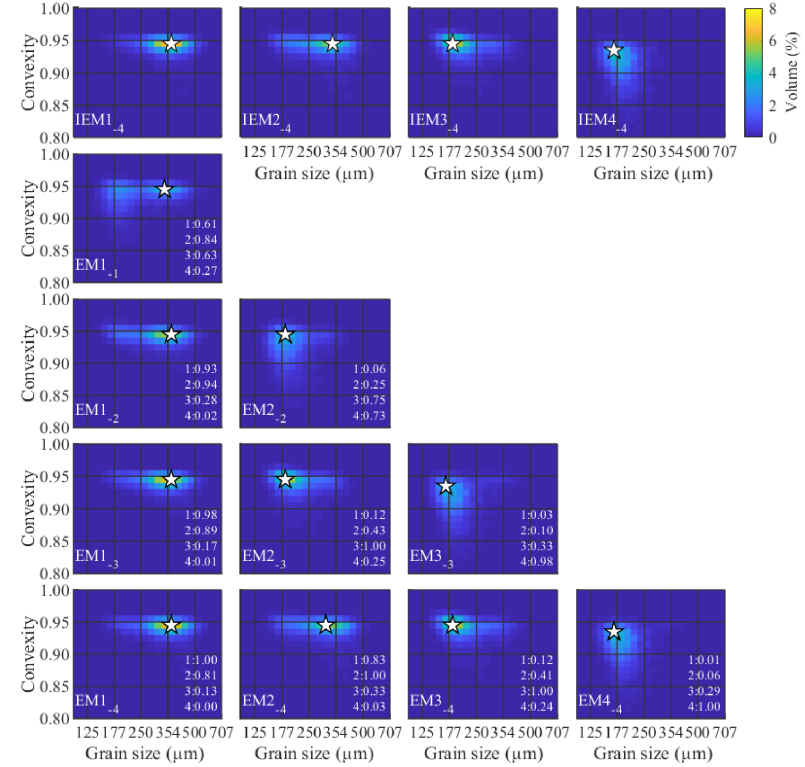
Figure A4. Input and determined endmember SSDs for the 4EM_noise dataset.